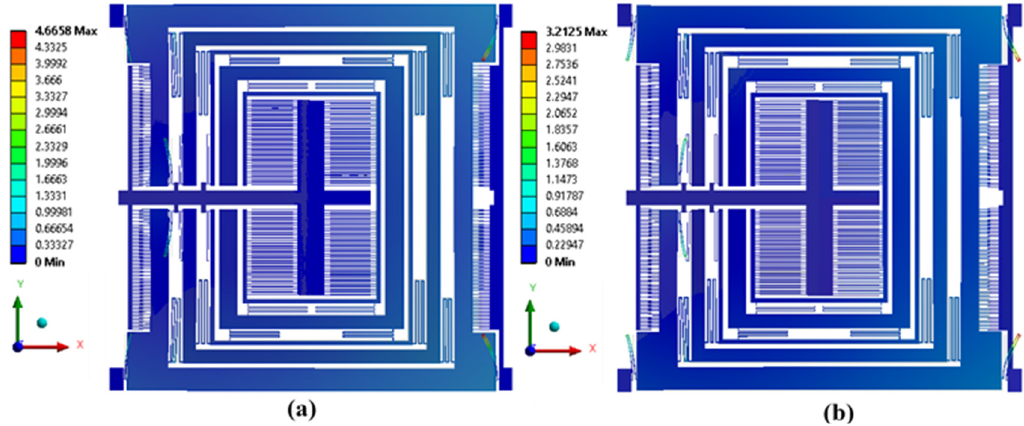
Figure 15. Young’s modulus of silicon in the temperature range of 40 °C to 100 °C.